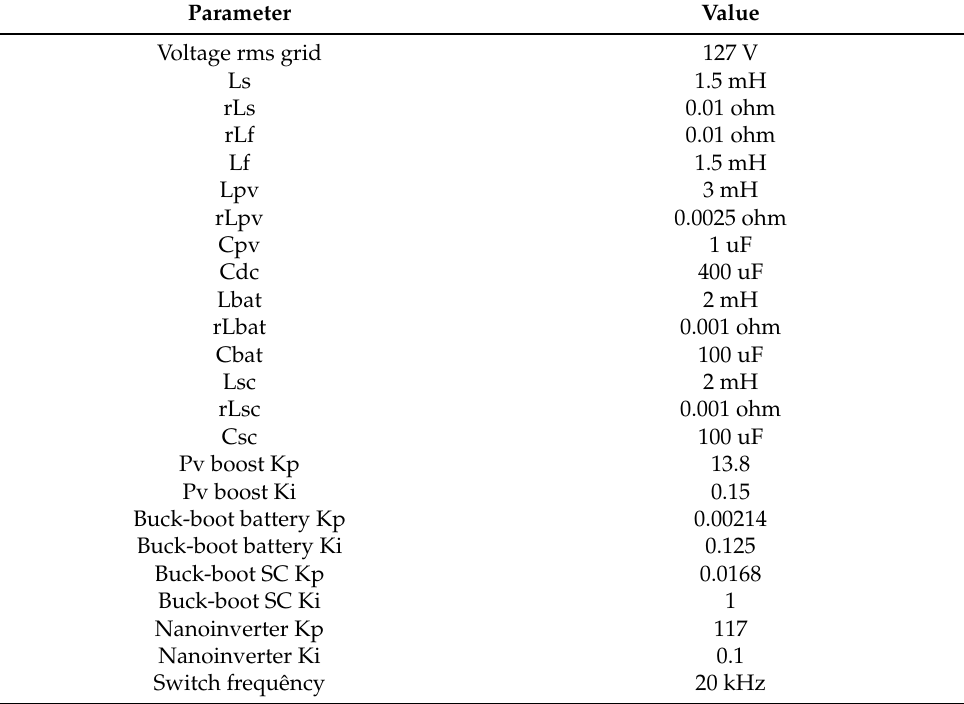
Table 1. Nanogrid and Control converters parameters.